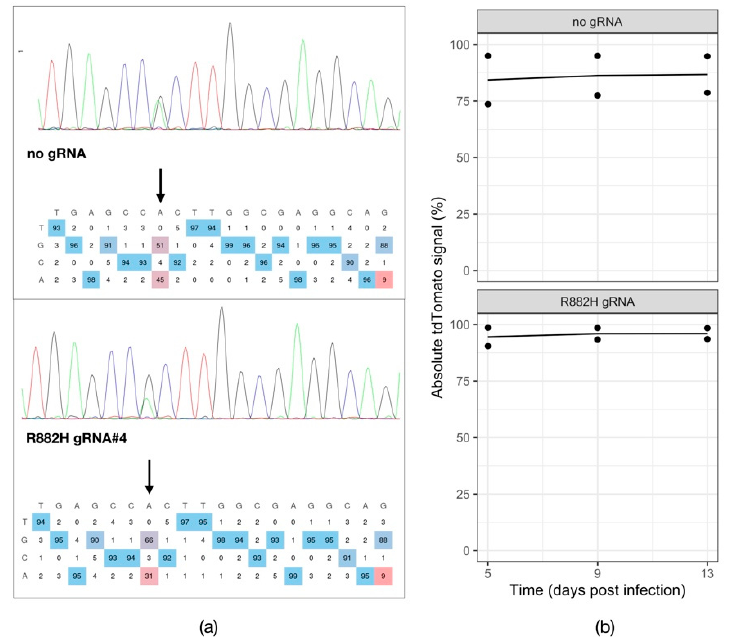
Figure 1. Testing the dependency of SET2 cells on mutant DNMT3A. ( a ) Chromatograms visualizing the Sanger sequencing reads of the PCR-amplified DNMT3A R882H genomic locus in SET2-ABE8e- GFP-Puro transgenic cell line expressing a tdTomato reporter alone (no gRNA) or in combination with a gRNA targeting the R882H mutation (R882H gRNA). ( b ) tdTomato reporter assay tracking the percentage of gRNA-expressing SET2-ABE8e-GFP-Puro cells over time ( n = 2).